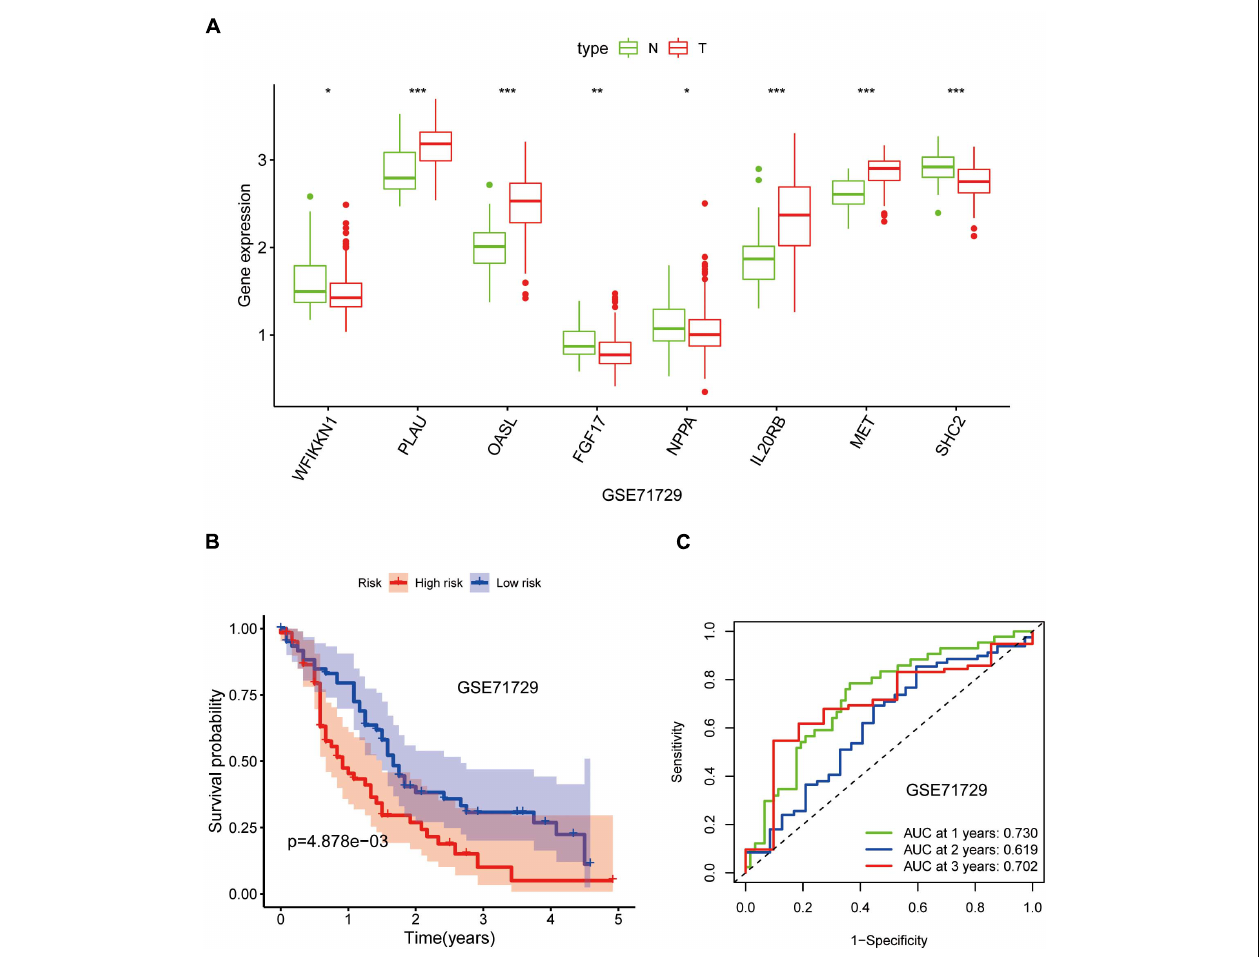
FIGURE 10 | Validation of the eight-gene signature in the Gene Expression Omnibus (GEO) database. (A) Expression of eight IRGs in tumor tissues and normal tissues in the GSE71729 database. (B) Kaplan–Meier curves for low- and high-risk groups in the GSE71729 database ( P < 0.01). (C) ROC curve for predicting survival from PAAD based on the risk score of the GSE71729 database. * p < 0.05; ** p < 0.01; *** p <